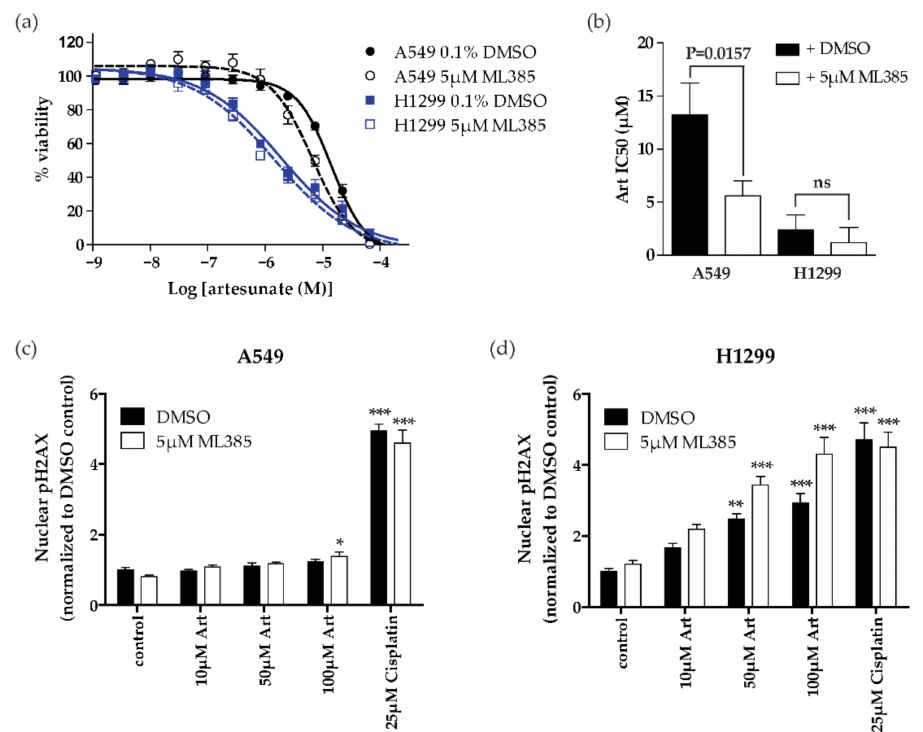
Figure 5. Pharmacological inhibition of NRF2 sensitizes A549 cells to artesunate ( a ) Artesunate was added to media with 0.1% DMSO (solid) or 5 µ M ML385 (dashed) and artesunate dose response data was normalized to DMSO or 5 µ M ML385 alone and is graphed as mean ± SD, n = 6. ( b ) The mean IC50 of artesunate in each cell line with 0.1% DMSO (solid) or 5 µ M ML385 (open) is graphed ± SD. p -values were calculated using a two-tailed t -test. ( c , d ) Quantification of nuclear pH2AX staining in A549 ( c ) and H1299 ( d ) cells that were pretreated for 24 h with 0.03% DMSO or 5 µ M ML385 followed by the addition of the indicated concentration of artesunate for an additional 24 h. Graphed as mean fold change ± SD in nuclear fluorescent intensity signal normalized to vehicle control cells pretreated with 0.03%. P-values calculate using a one-way ANOVA with Dunnett’s multiple comparison test comparing each artesunate concertation to the matched control after normalization (** p < 0.01; *** p <